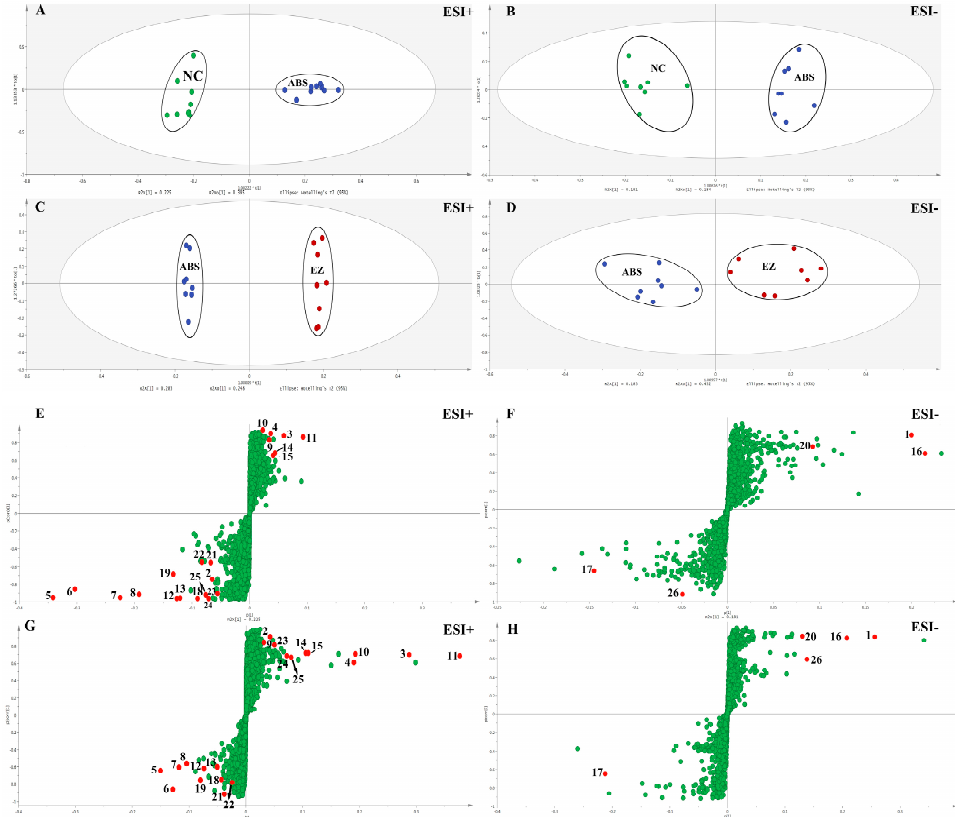
Figure 3. OPLS-DA model results of plasma metabolic profiling of NC/ABS and ABS/EZ in ESI+ mode ( A , C ) and ESI − mode ( B , D ); OPLS-DA s-plots of plasma metabolic profiling of NC/ABS and ABS/EZ in ESI+ mode ( E , G ) and ESI − mode ( F , H ). Note: The numbered red dots represent 26 potential biomarkers respectively, which are shown in Table